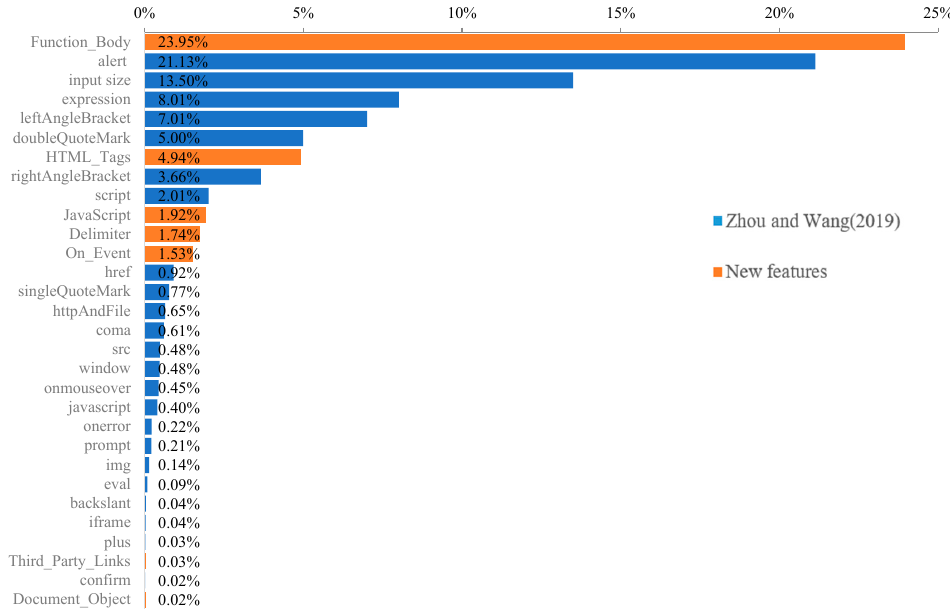
Figure 4. Assess the importance of the features of Zhou and Wang (2019) [1] and the newly proposed features in this paper.